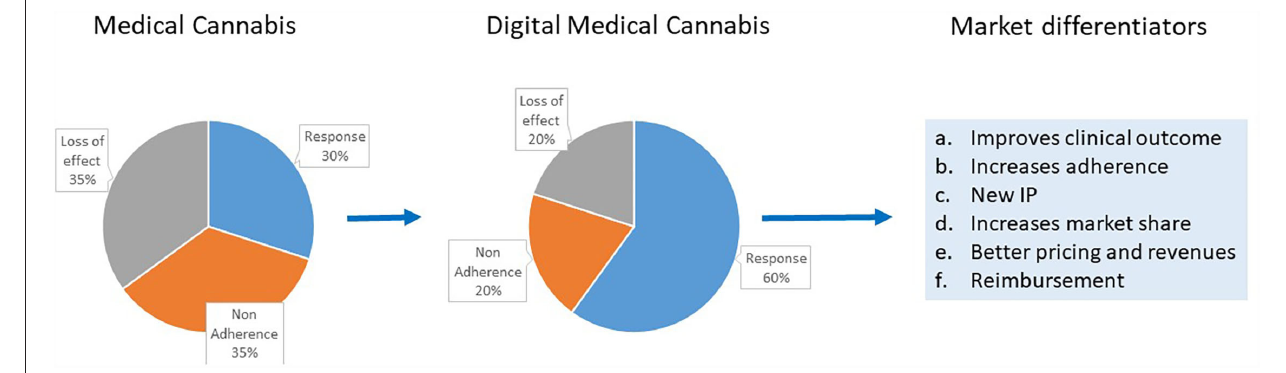
FIGURE 1 | Schematic presentation of the advantages to all players in the cannabis field from digital medical cannabis use and the current medical cannabis products use. Some of the market differentiators provided by digital medical cannabis are highlighted.